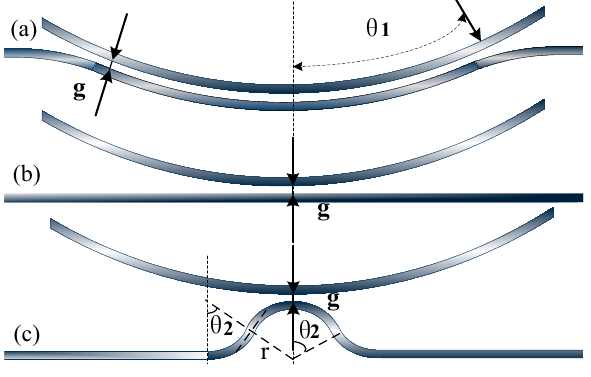
Figure 4. Fabrication process of optical micro-cavity.